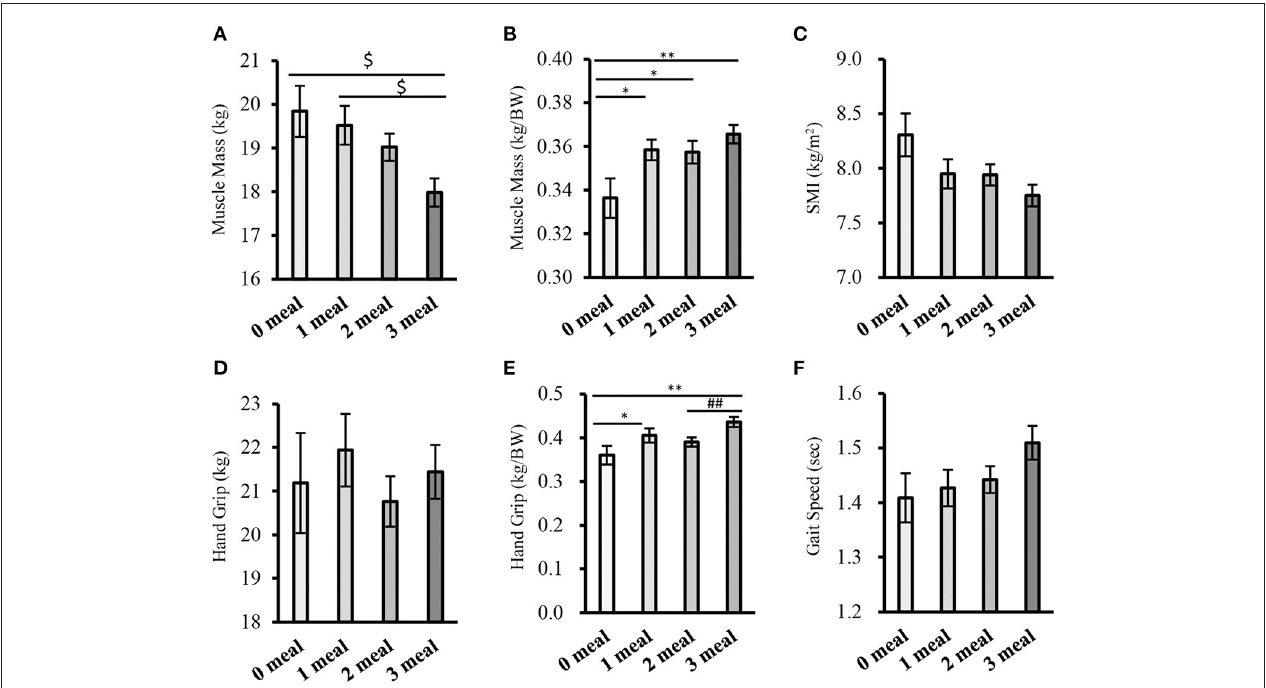
FIGURE 3 | Comparison of sarcopenia-related factors by the number of meals meeting 0.4g/kg BW (cross-sectional study 2-1). (A) Muscle mass, (B) Muscle mass (corrected for body weight), (C) SMI, (D) Handgrip strength, (E) Handgrip strength (weight-corrected), (F) Gait speed. Values are expressed as mean and standard error. $ P < 0.05 compared to 3 meals (one-way ANOVA), * P < 0.05, ** P < 0.01 compared to 0 meal (Mann-Whitney), ## P < 0.01, compared to 3 meals (Mann-Whitney), BW, Body Weight; SMI, Skeletal Muscle